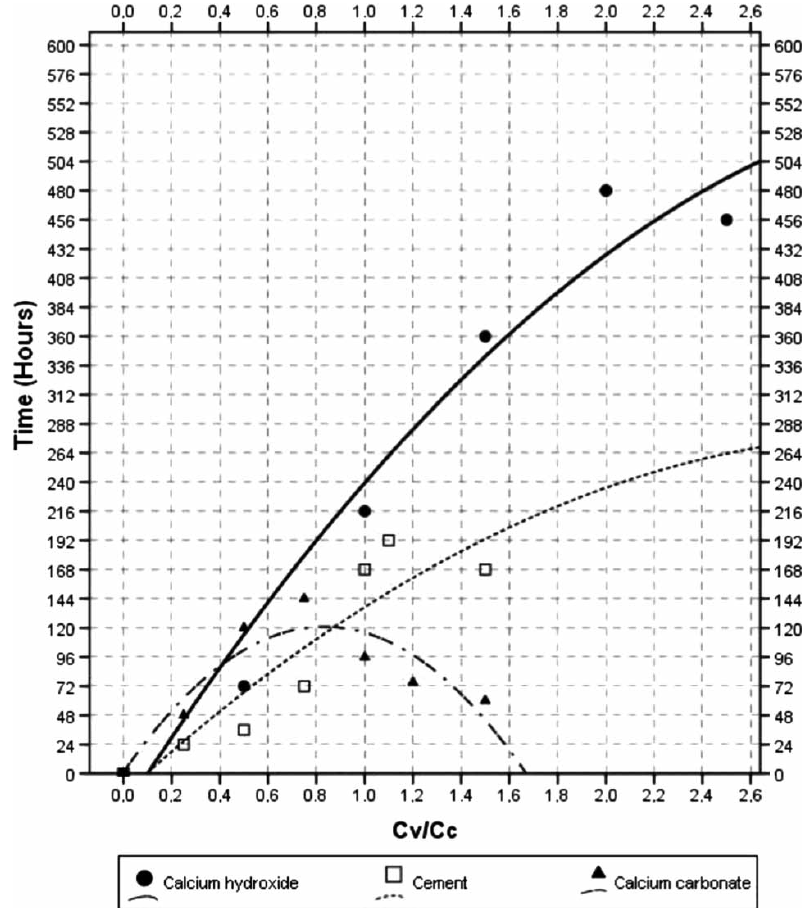
Fig. 6. Determination of the optimal filler content, analyzing the time to obtain 45%